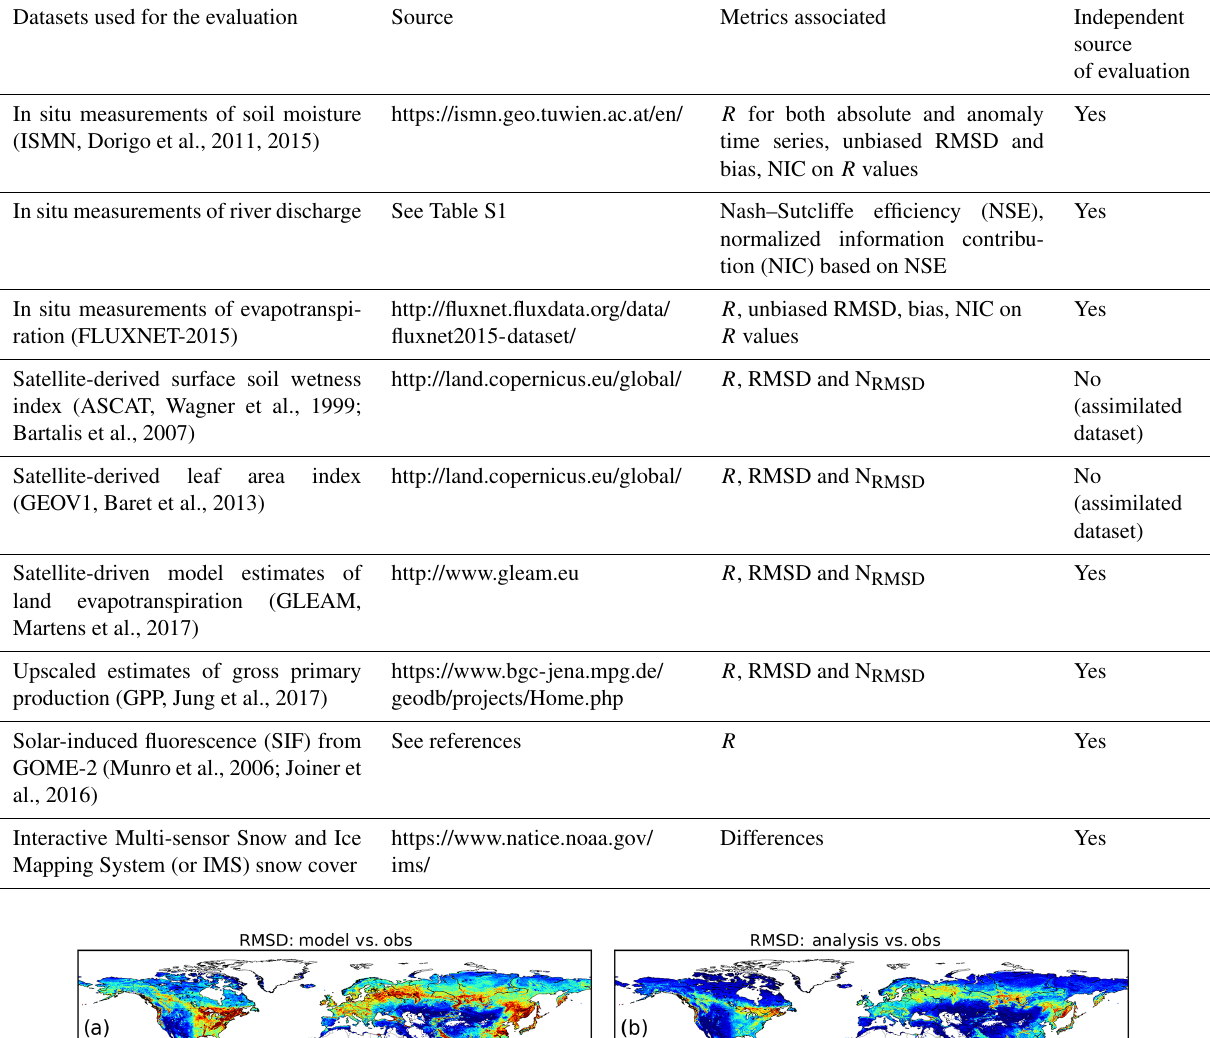
Table 3. Evaluation datasets and associated metrics used in this study. All URLs in this table were last accessed in August 2020. Datasets used for the evaluation